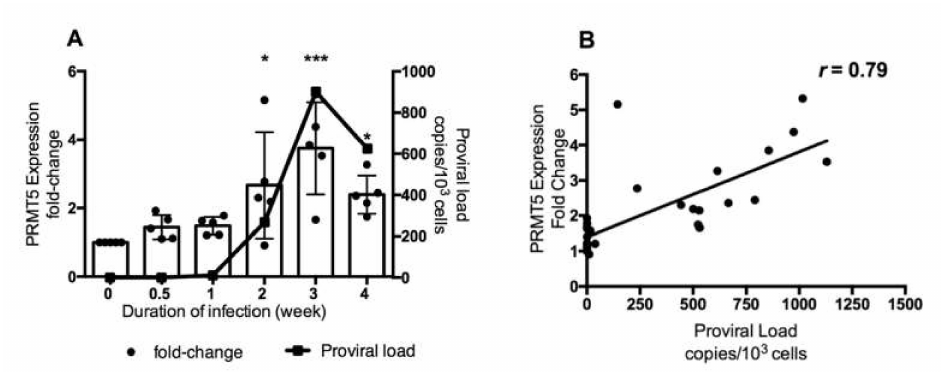
Figure 2. Change in PRMT5 expression at the RNA level in response to experimental BLV infection during the early stage of infection. ( A ) Five BLV-negative Japanese black calves carrying susceptible alleles BoLA-DRB3*1601 / *1601 were experimentally challenged intravenously with BLV, and RNA and DNA were extracted from these animals at six time points during the first month of infection. The BLV PVL was measured by CoCoMo-qPCR using genomic DNA. PRMT5 expression was measured by qRT-PCR using RNA and the fold-change was calculated using the ∆∆ CT method with normalization to GAPDH expression as an internal control. Samples were run in duplicate. A combined bar and line graph show the mean of PRMT5 expression fold-change at each point (bar graph and left axis) with the corresponding mean of proviral load (line graph and right axis). Error bars represent the standard deviation of the PRMT5 fold-change of five cattle, p value was calculated using the Kruskal-Wallis